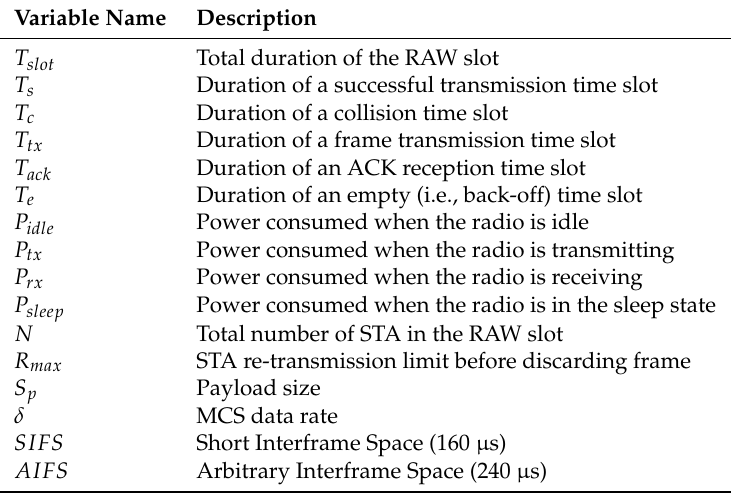
Table 1. Variables introduced in the Markov process model.